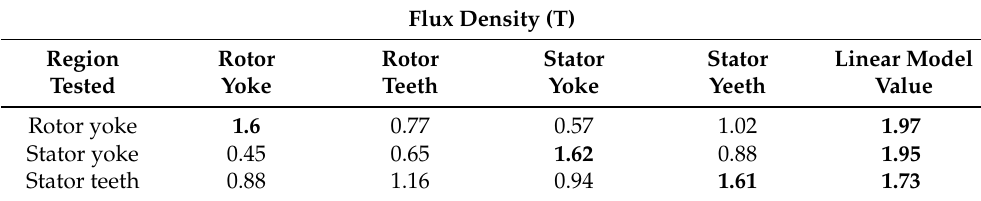
Table 4. Evaluation of the saturation effect on the induced voltage.